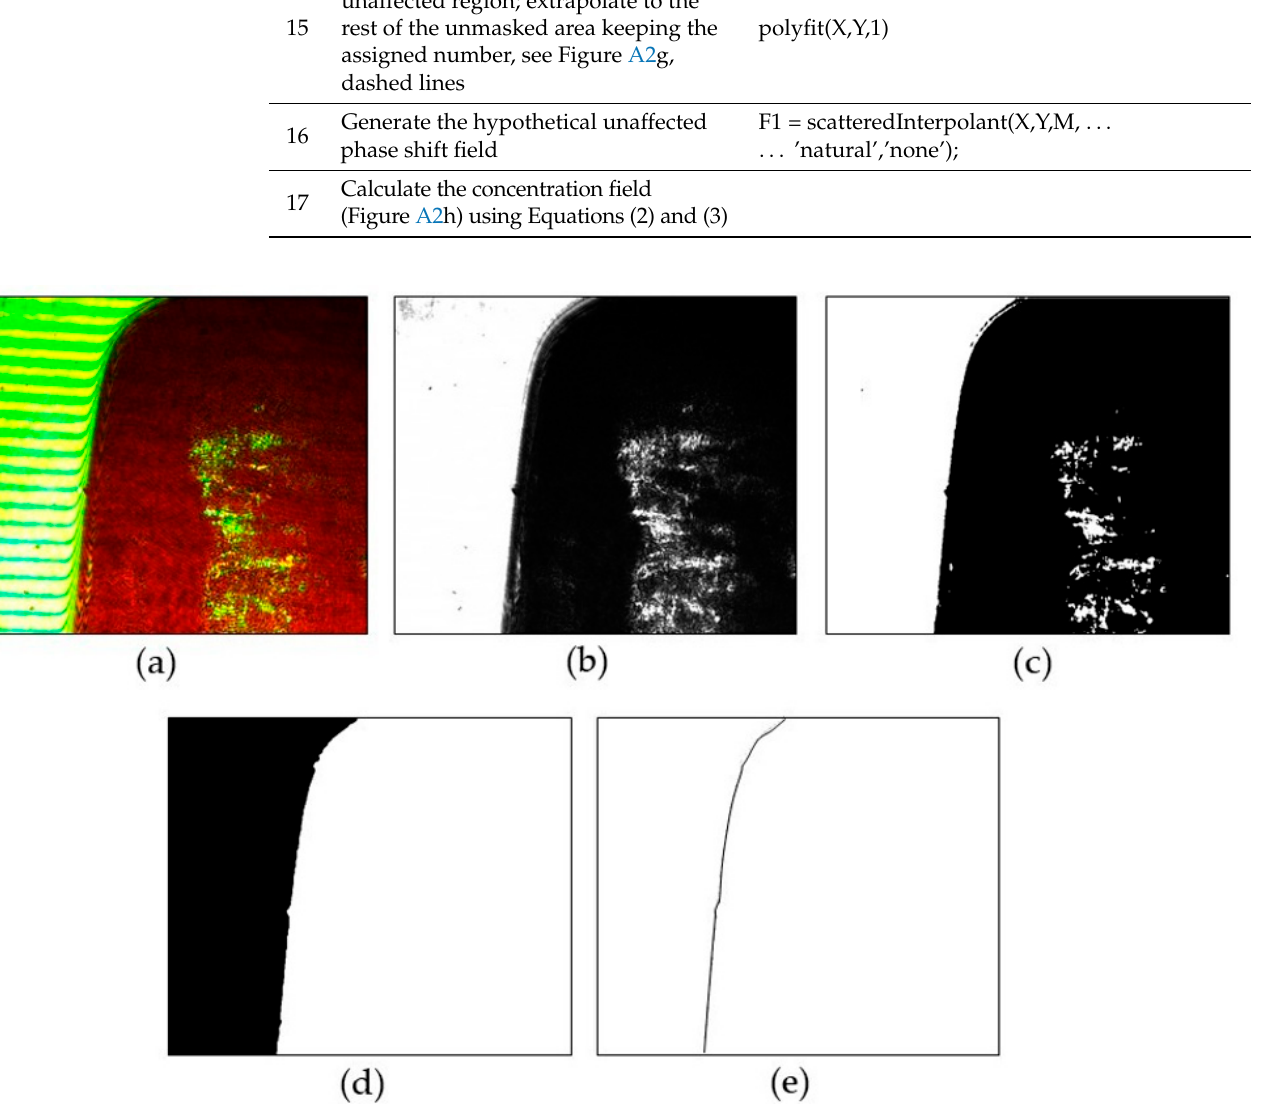
Figure A1. Image processing of the green channel images: ( a ) original image, ( b ) green channel, ( c ) binarized image, ( d ) segmented crystal after morphological opening, ( e ) crystal outline.